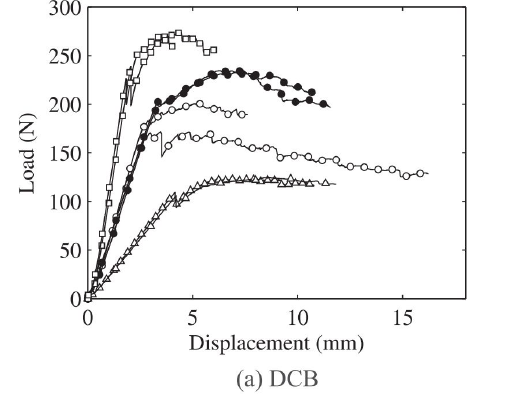
Figure 12. Force – displacement graphs obtained from DCB experiments 8